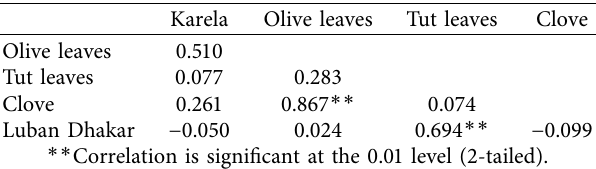
Table 5: Correlations between the five different medicinal plants associated with the fourteen measured elements.